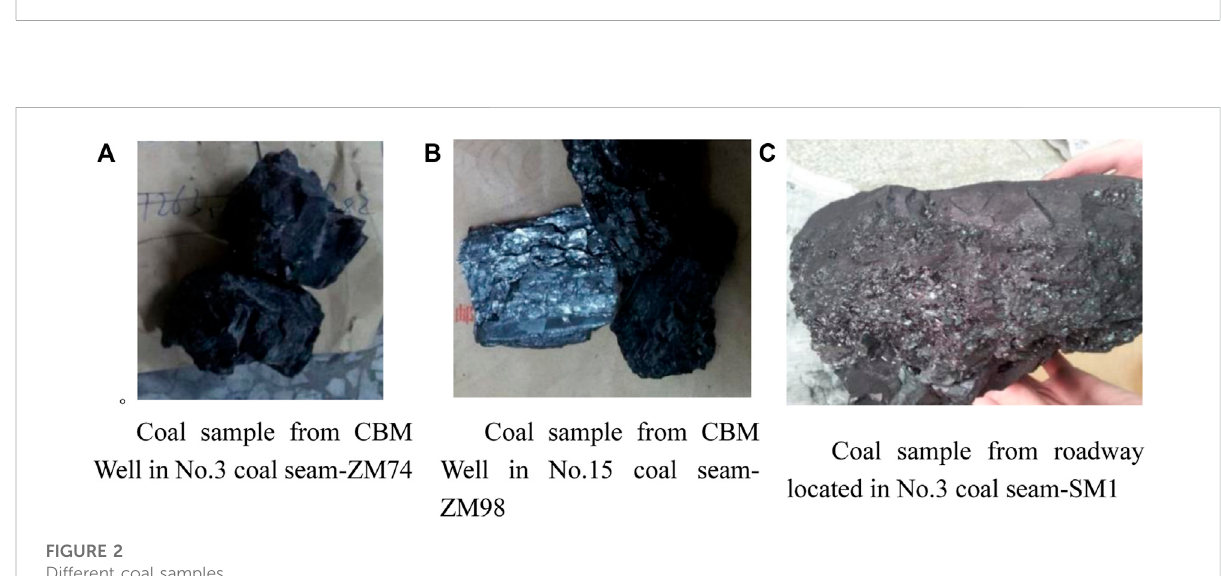
and the striation color is dark black, showing glass-strong glass luster. Endogenous fi ssures are not well developed; and irregular and conchoidal fractures can be observed. The natural fractures of roadway coal samples mainly exist in the form of horizontal fractures, while the natural micro-fractures of coal in CBM Wells mainly develop along the vertical direction, parallel to the wellbore direction, which is related to the coal sedimentary